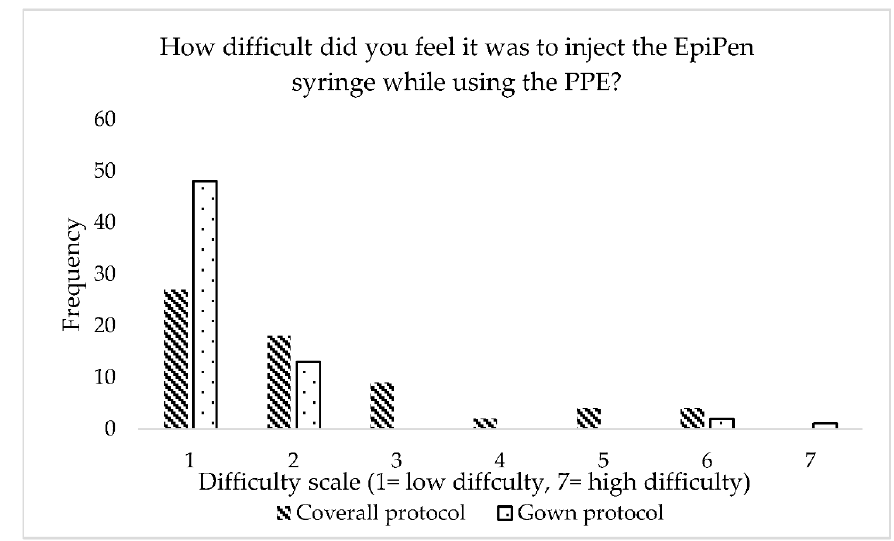
Figure 6. Difficulty in providing a medical care rating from the perception questionnaire after using the two protocols: coverall protocol and gown protocol.